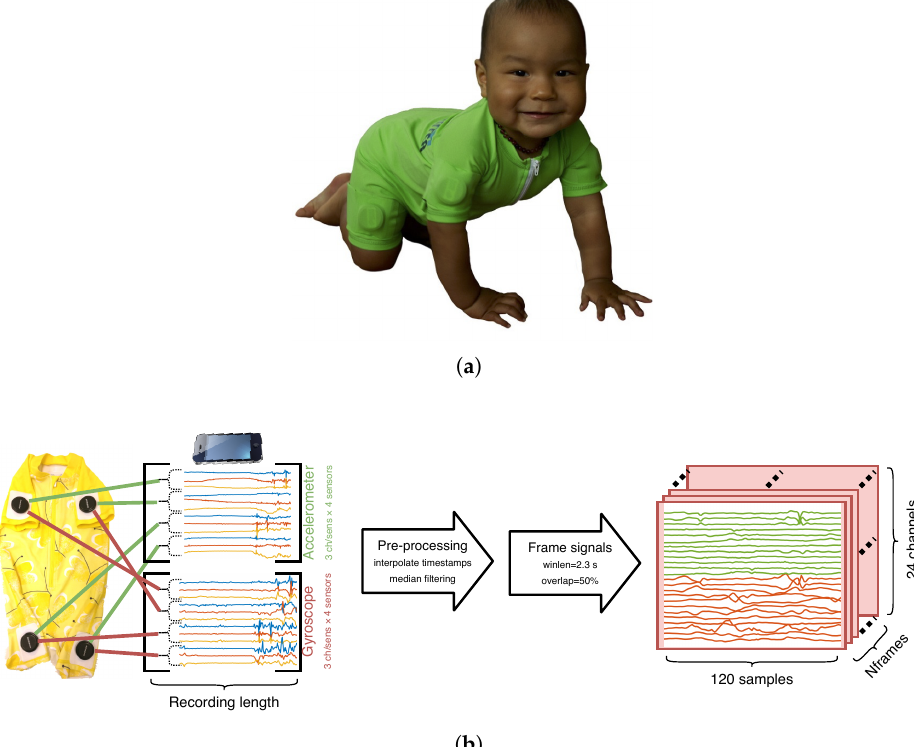
Figure 1. The Maiju jumpsuit. The picture in ( a ) is published with parental consent. ( a ) The Maiju jumpsuit worn by a 10-month-old infant. ( b ) Illustration of the recording setup and data preprocessing steps. The green and red lines from the sensors denote the accelerometer and gyroscope data,